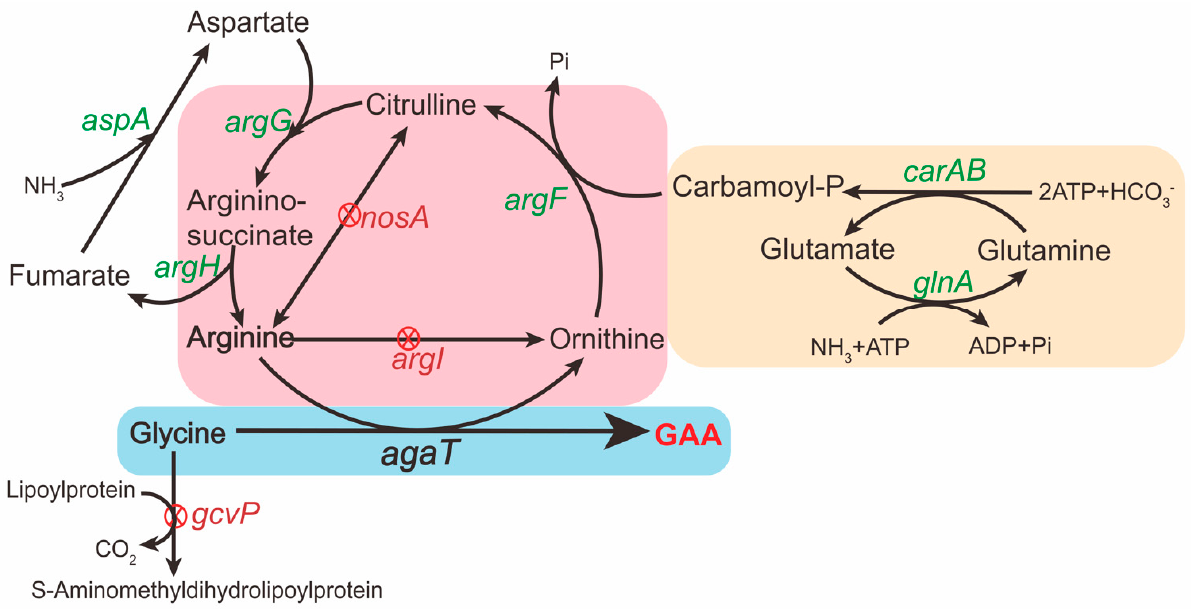
Figure 1. Schematic presentation of the GAA production in B. subtilis . The green font indicates overexpression of the corresponding genes on the genome of B. subtilis . The red “X” in a red circle indicates deletion of the corresponding genes. The ornithine cycle in B. subtilis is included in the pink box. The heterogeneous GAA synthesis pathway in B. subtilis is included in the blue box. The pathway in the yellow box is to promote the endogenous ornithine cycle in B. subtilis . To screen for the best promoter that regulates AgaT expression with the highest intensity, we attached a green fluorescent protein (GFP, accession no. AAG29470.1) after AgaT by a short linker (GGAGGAGGATCTGGAGGCGG), and strains B2-1, B2-2, B2-3,